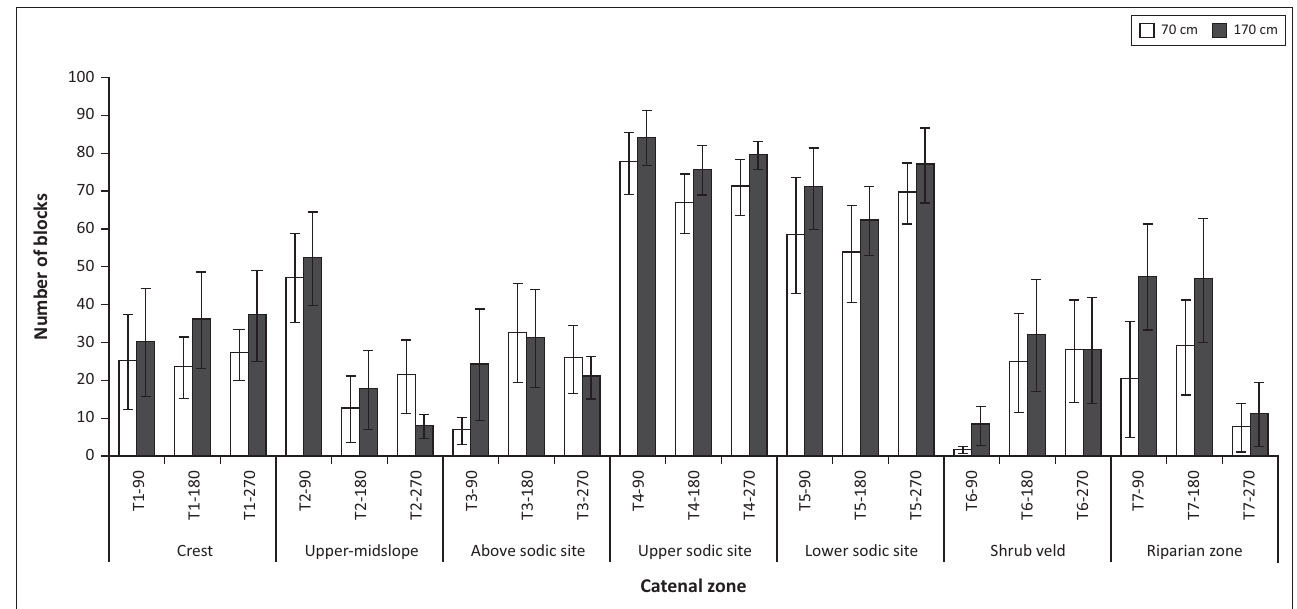
FIGURE 3: Average number of blocks visible on a 1 m 2 checkerboard in each transect at three angles to the transect line (90°, 180° and 270°). Standard error bars are also indicated. Observations were performed at 20 m intervals with a line distance of 100 m and the average number of blocks visible per line is indicated. Two observation heights were used – the observer sitting on the ground (eye level at 70 cm) and the observer standing (eye level at 170